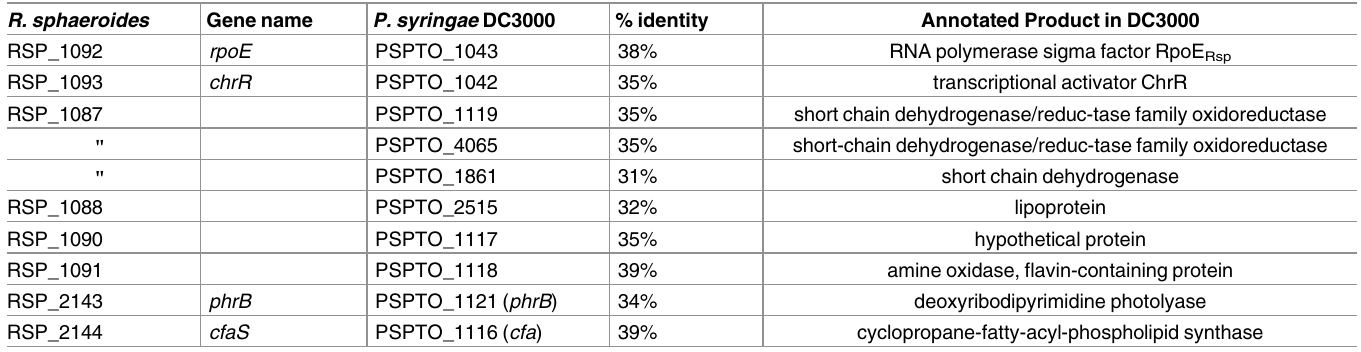
Amino acid sequences corresponding to several genes from Rhodobacter sphaeroides were aligned against the translated DC3000 genome using tblastn on the NCBI’s BLAST server [26]. For each R. sphaeroides gene, the gene from P. syringae DC3000 containing the highest scoring alignment is listed along with the percentage of identity between the two genes, along with the predicted function of the